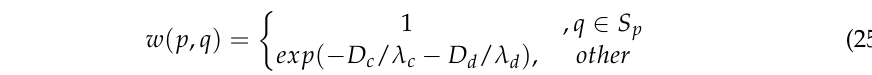
Among them, λ c and λ d are color and distance factors, which are used to adjust the influence of color difference and distance on